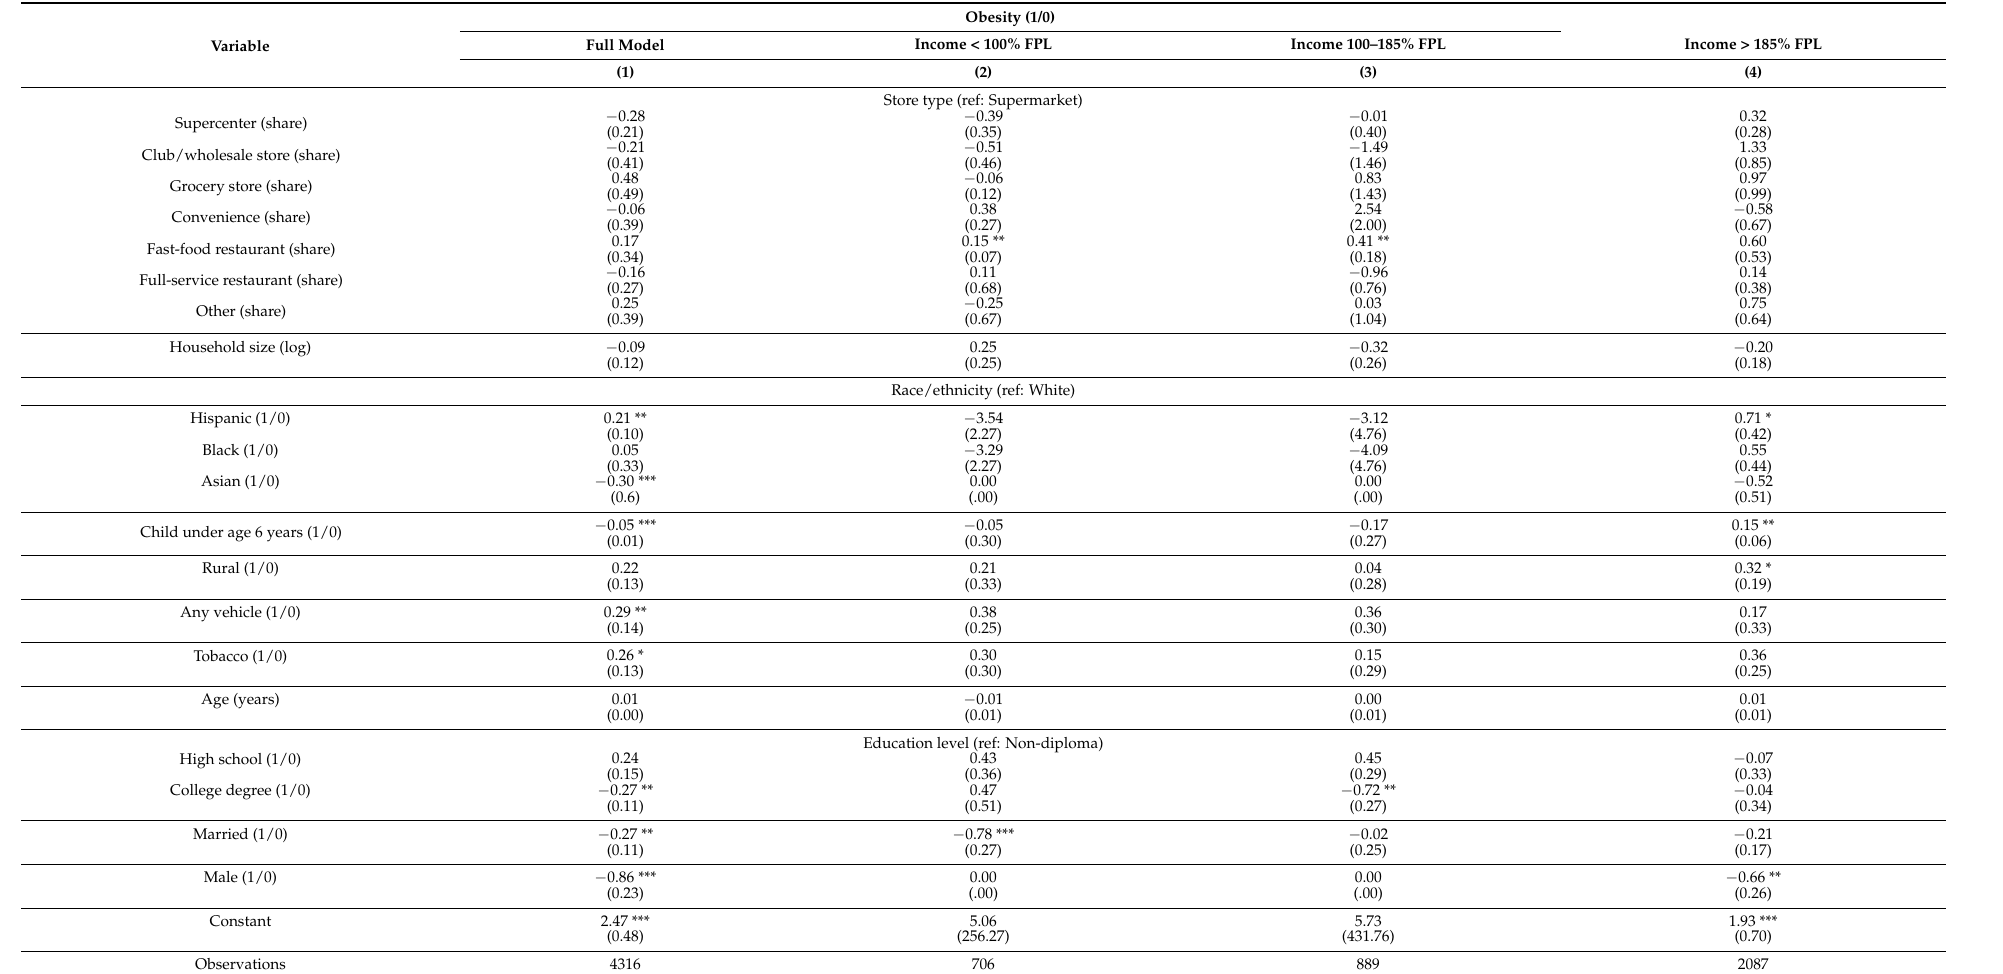
Table 5. Association of incidence of obesity and food budget share at different stores and